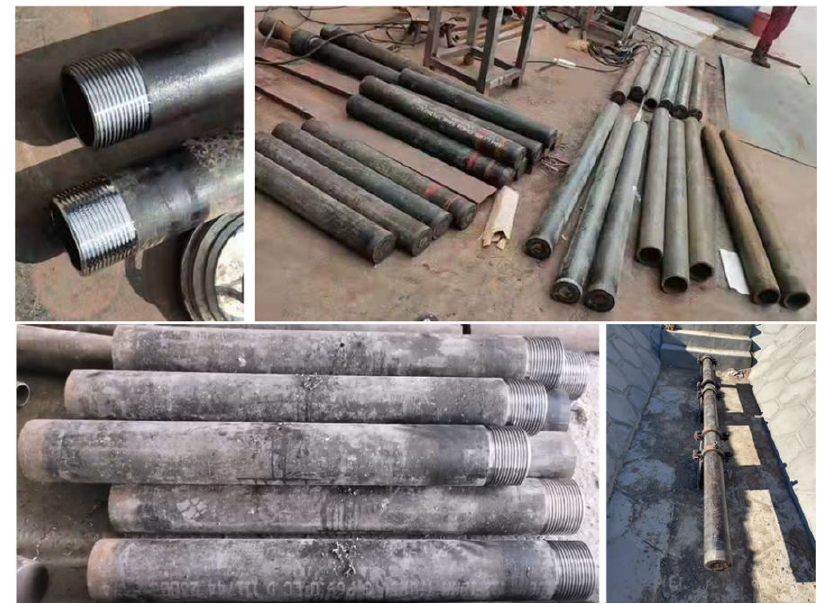
Figure 3. Photos of steel casing